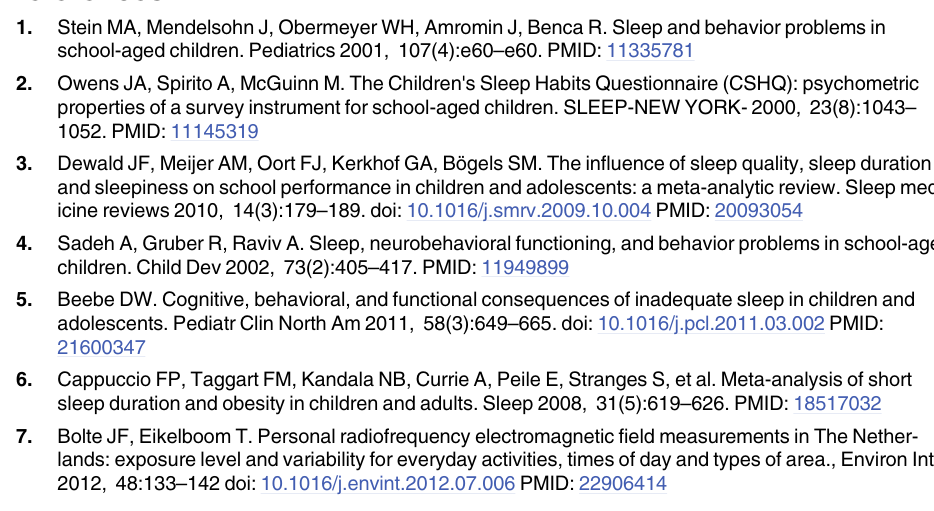
S1 Table. Minimally-adjusted association between RF-EMF exposure sources and those sleeping problems a priori hypothesized to be potentially related to RF-EMF exposure. Models adjusted for child's sex and age. S2 Table. Minimally as well as fully-adjusted association between mobile phone ownership at age 7 and sleeping problems. Minimally adjusted: model adjusted for child's sex and age. Fully adjusted: model adjusted for maternal educational level, parental financial situation, parental countries of birth, maternal and paternal age, and child's sex, age, and number of sib- lings. S3 Table. Minimally-adjusted association between RF-EMF exposure sources and those sleeping problems a priori NOT hypothesized to be potentially related to RF-EMF expo- sure. Models adjusted for child's sex and